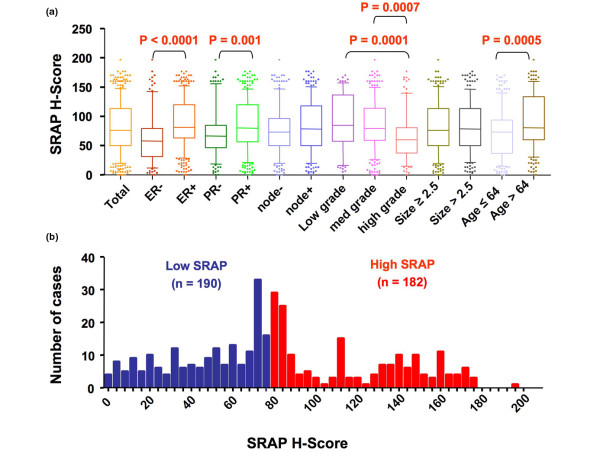
Distribution of SRAP H-scores in 372 breast cancer cases. (a) Box and whiskers representation showing the distribution of steroid receptor RNA activator protein (SRAP) H-scores in the whole cohort (Total) and in different subgroups. For each group the median is depicted by the thick horizontal bar, the box delineates 25th to 75th percentiles and the whiskers 10 to 90 percentiles (b) Frequency distribution of SRAP H-scores in the whole cohort (Total). Median H-score of 76.67 delineates Low SRAP and a High SRAP subgroups.